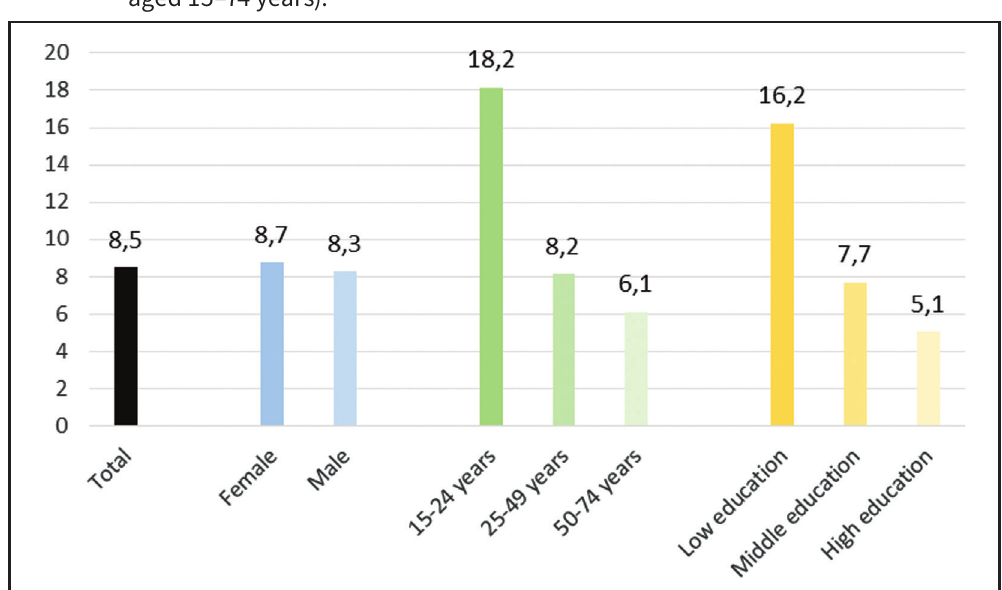
Figure 1 Unemployment rate for different types of workers (2016, average of the 24 con- sidered European countries, in the percentage of the corresponding labor force aged 15–74